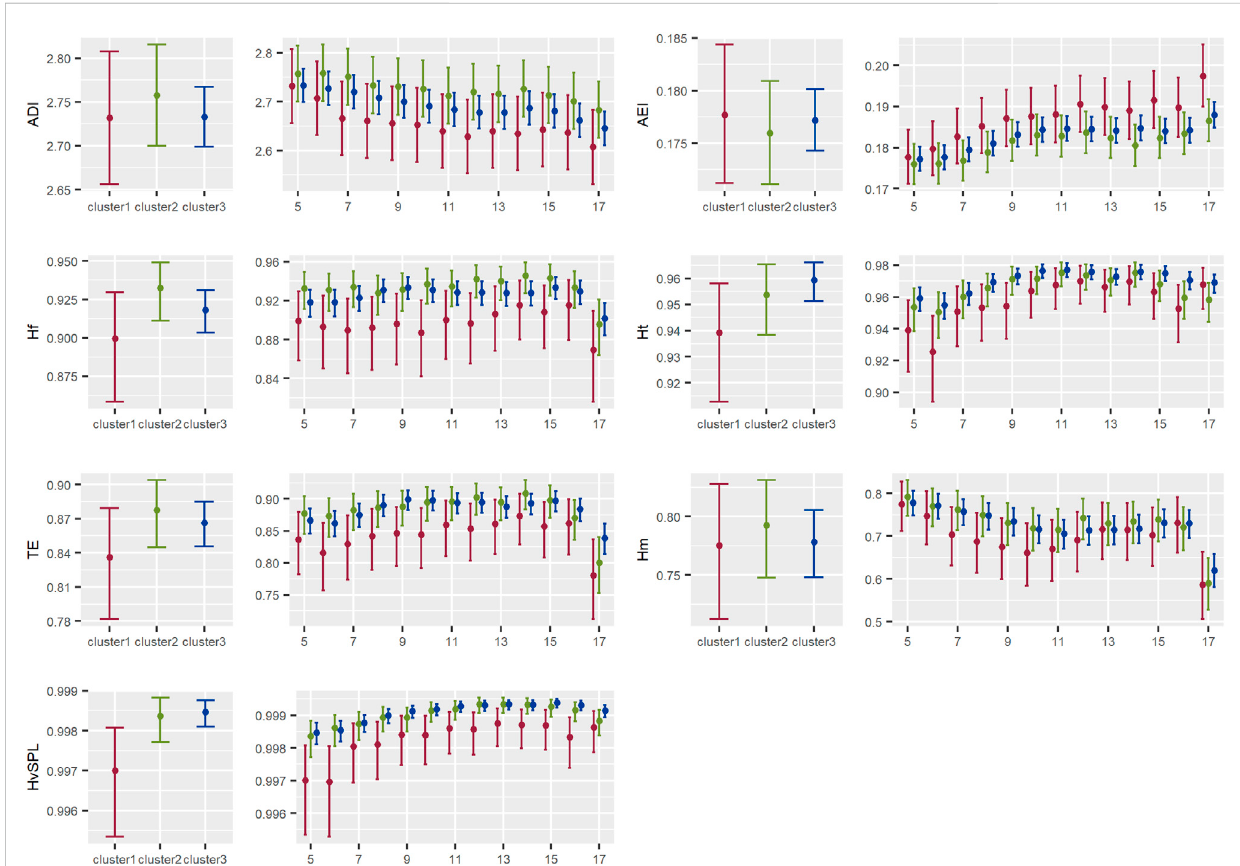
Results of the models showing the contrast between acoustic indices by cluster for the entropy and acoustic diversity type of indices in the Central Conservation Area of Costa Rica, 2019 –